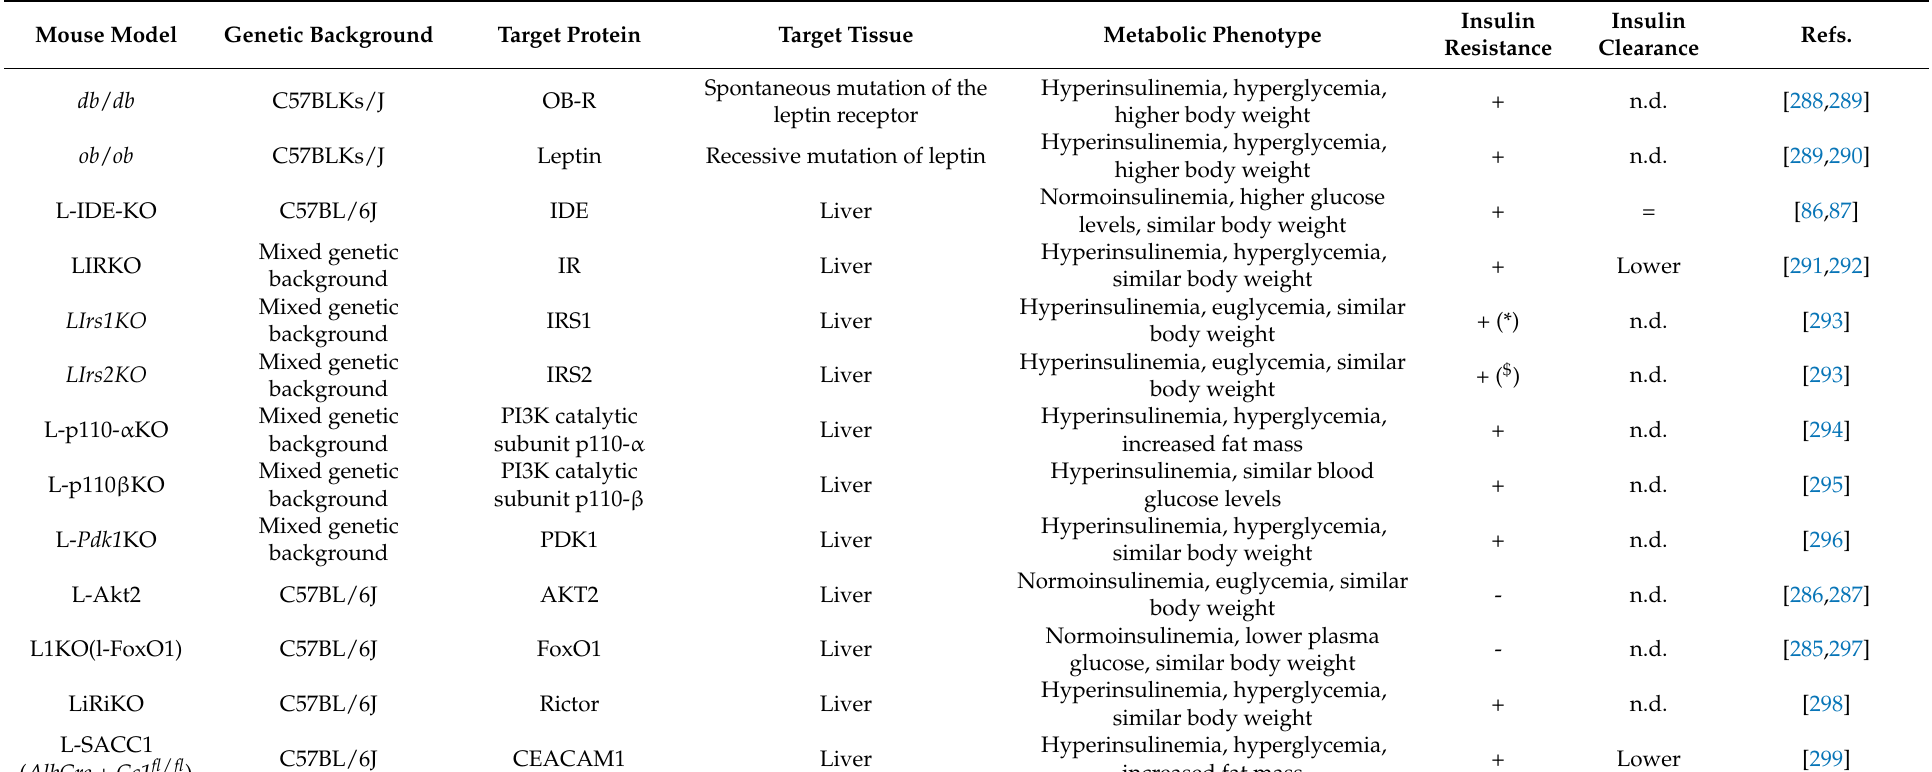
Table 3. Knockout mice models of hepatic insulin